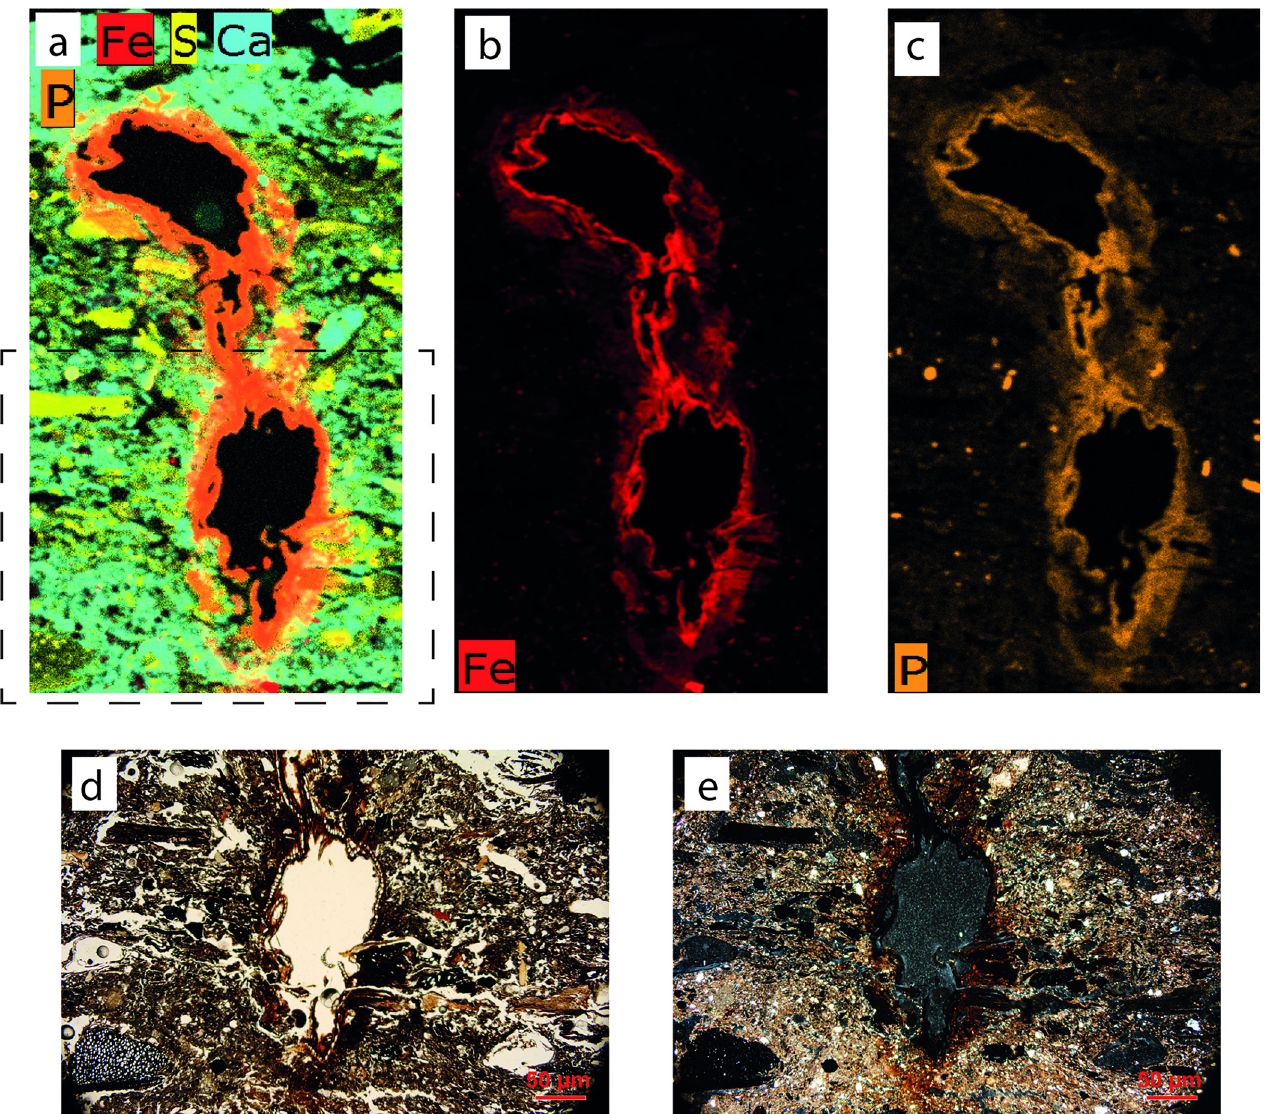
Fig 14. Fe- and P-rich hypocoating around a root channel. (a) multi-elemental μ XRF map showing the abundance of Fe, S, Ca, and P. The dashed rectangle indicates the area shown in (d) and (e); (b, c) Same as (a), showing only the distribution of Fe and P respectively; (d) Microphotograph showing a detail of the root channel and of the hypocoating associated to it (PPL); (e): same as (d),